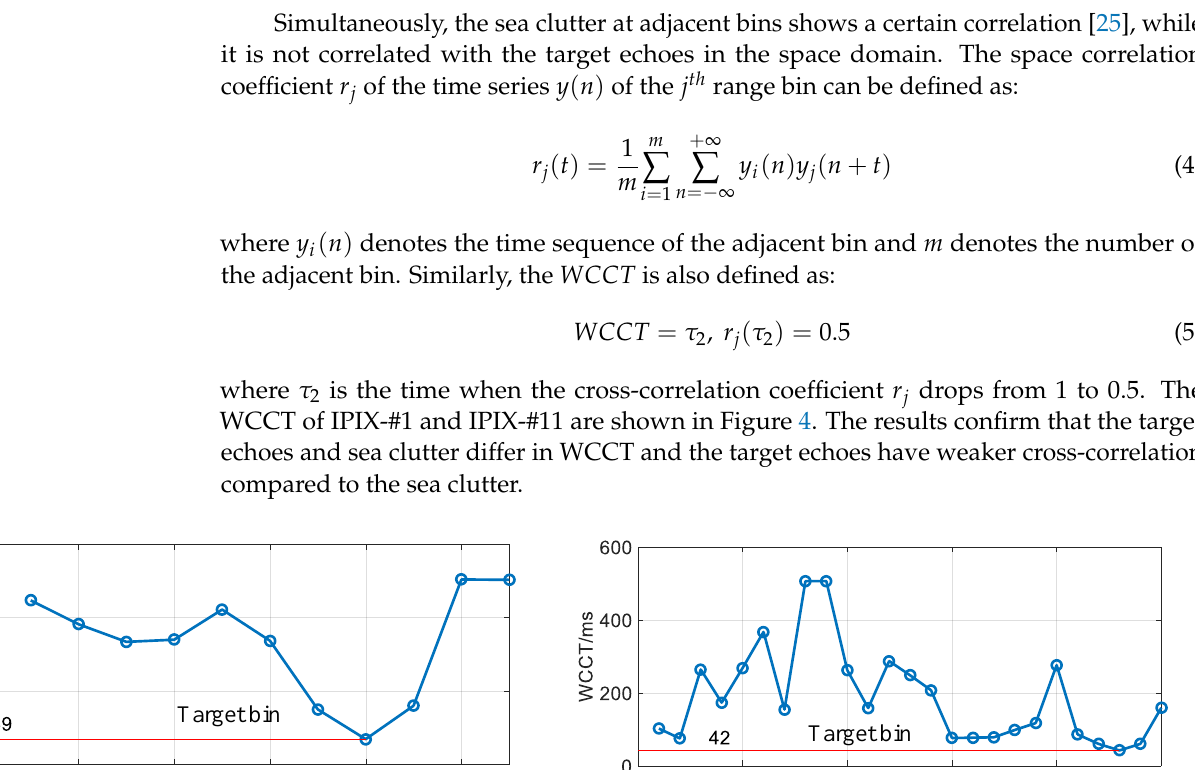
Figure 4. Diagram of the WCCT. ( a ) WCCT of IPIX-#1. ( b ) WCCT of IPIX-#11.